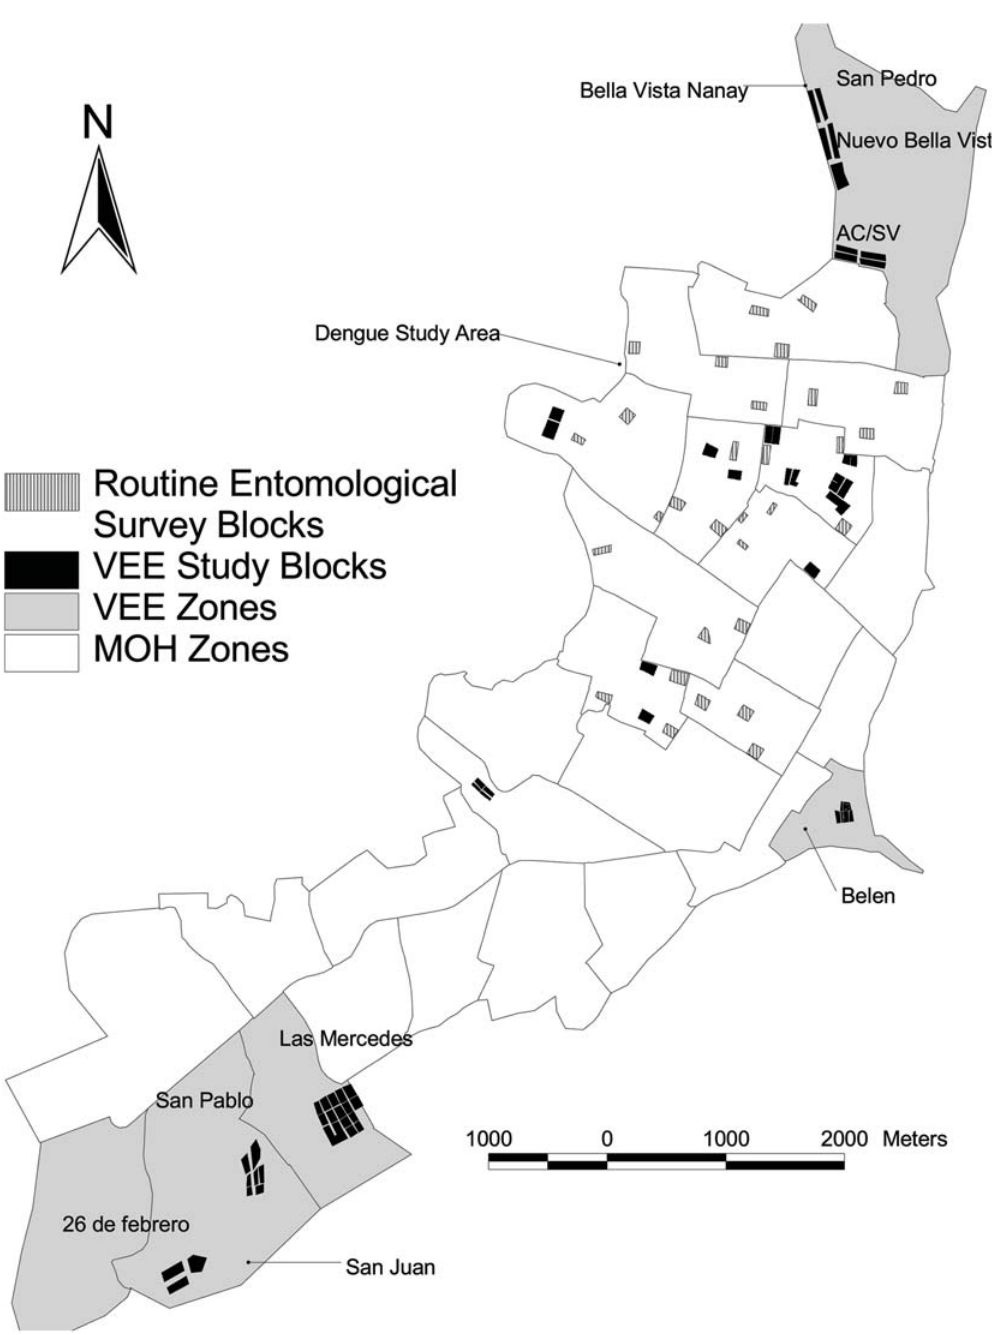
Figure 1. Map of Iquitos showing the locations of the 4 major study areas. The neighborhoods where active VEE cases were identified are shown in grey and the study blocks are shown in black. Study blocks in the dengue study area (white background) are also shown in black. The blocks where routine entomological surveys were carried out between January 2006 and January 2007 are shown in black and white stripes.